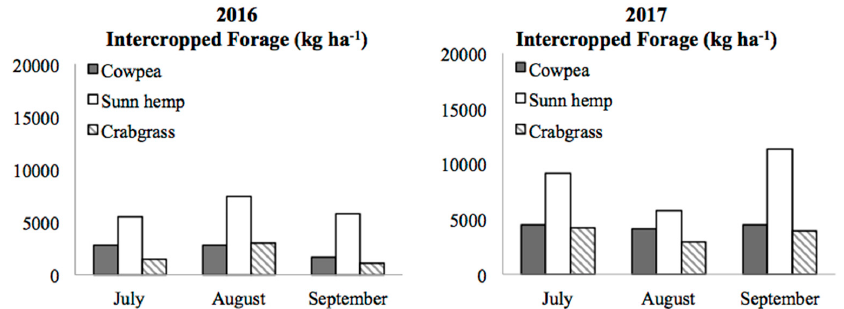
Figure 2. Herbage mass differences ( p < 0.05) of the forage crops intercropped with corn during the growing season in 2016 and 2017.